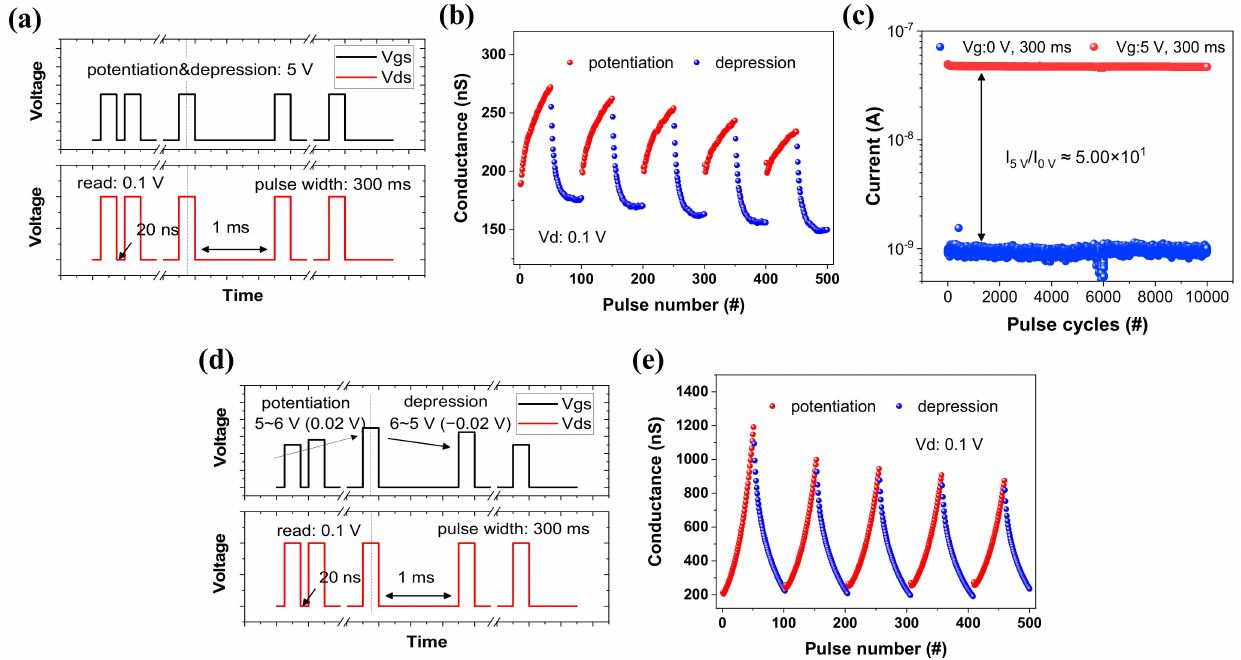
Figure 5. ( a ) By applying a pulse to the gate terminal (black line) and drain terminal (red line), ( b ) the conductance update of potentiation (red)/depression (blue). The pulse width is 300 ms and the amplitude is 5 V (at V d = 0.1 V). In potentiation, an interval time has 20 ns, while it is 1 ms in depression. ( c ) The pulse endurance of the activated (red) and steady (blue) state during 10,000 cycles. The gate pulse is designed 5 V/300 ms for activation, and 0 V/300 ms for stabilization. ( d ) The increasing/decreasing pulse design: in potentiation and depression, 5~6 V/300 ms (step: 0.02 V) and 5~6 V/300 ms (step: − 0.02 V) are applied as the input signals, respectively. ( e ) The conductance update from ( d ) gets more linear compared with that in ( b